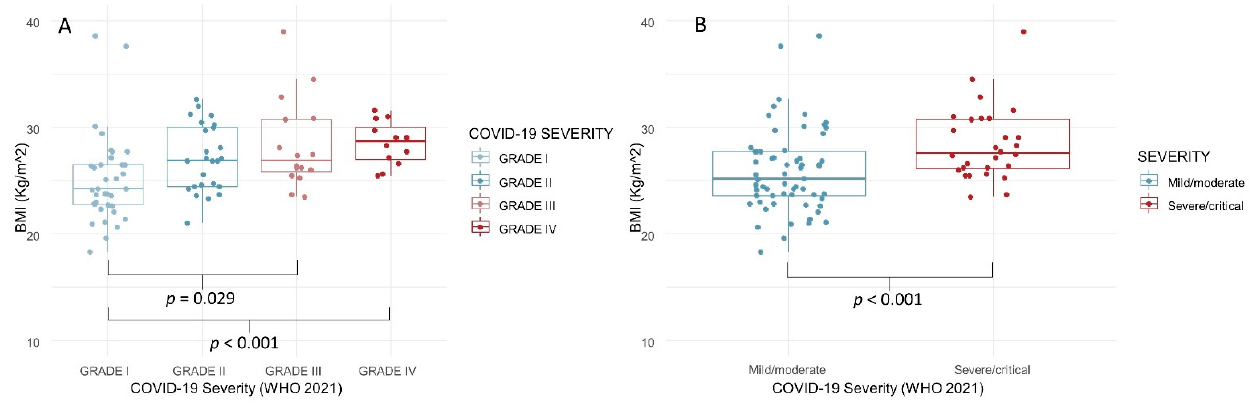
Figure 2. BMI of COVID-19 survivors, according to disease severity (4 grades, ( A ); 2 grades, ( B )). BMI (body mass index). Table 1. Mean ± standard deviations, median (in italics) and 25th–75th percentile (in brackets) of relevant variables stratified by COVID-19 severity.